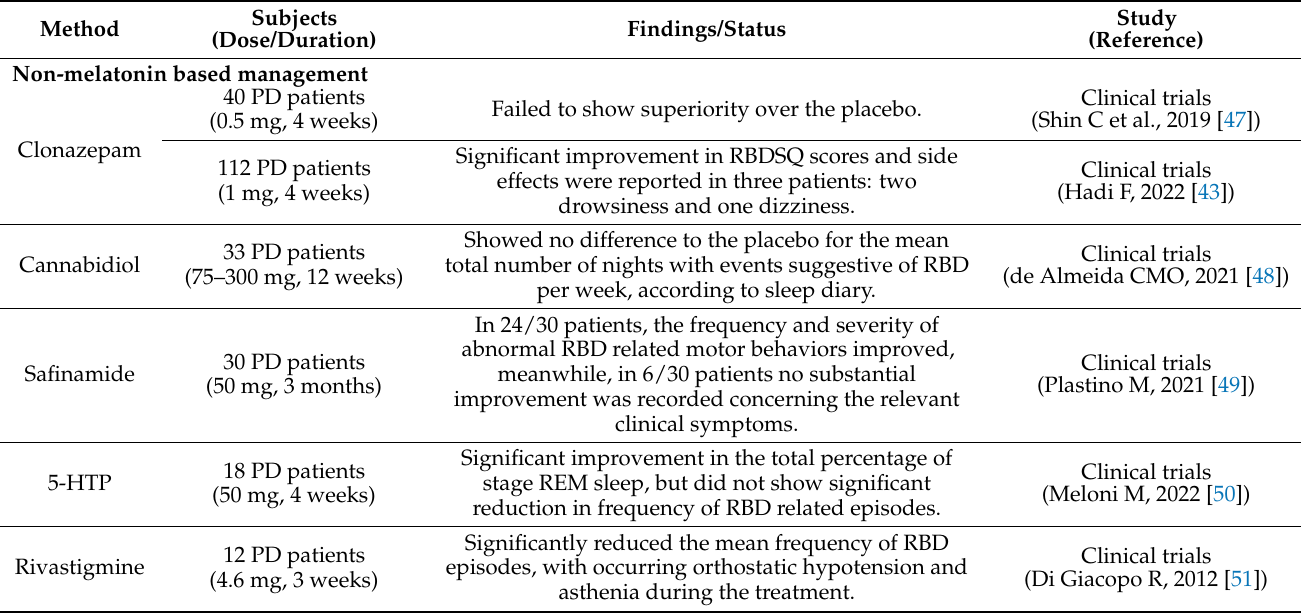
Table 1. RBD in Parkinson’s disease and their management supported by randomized controlled